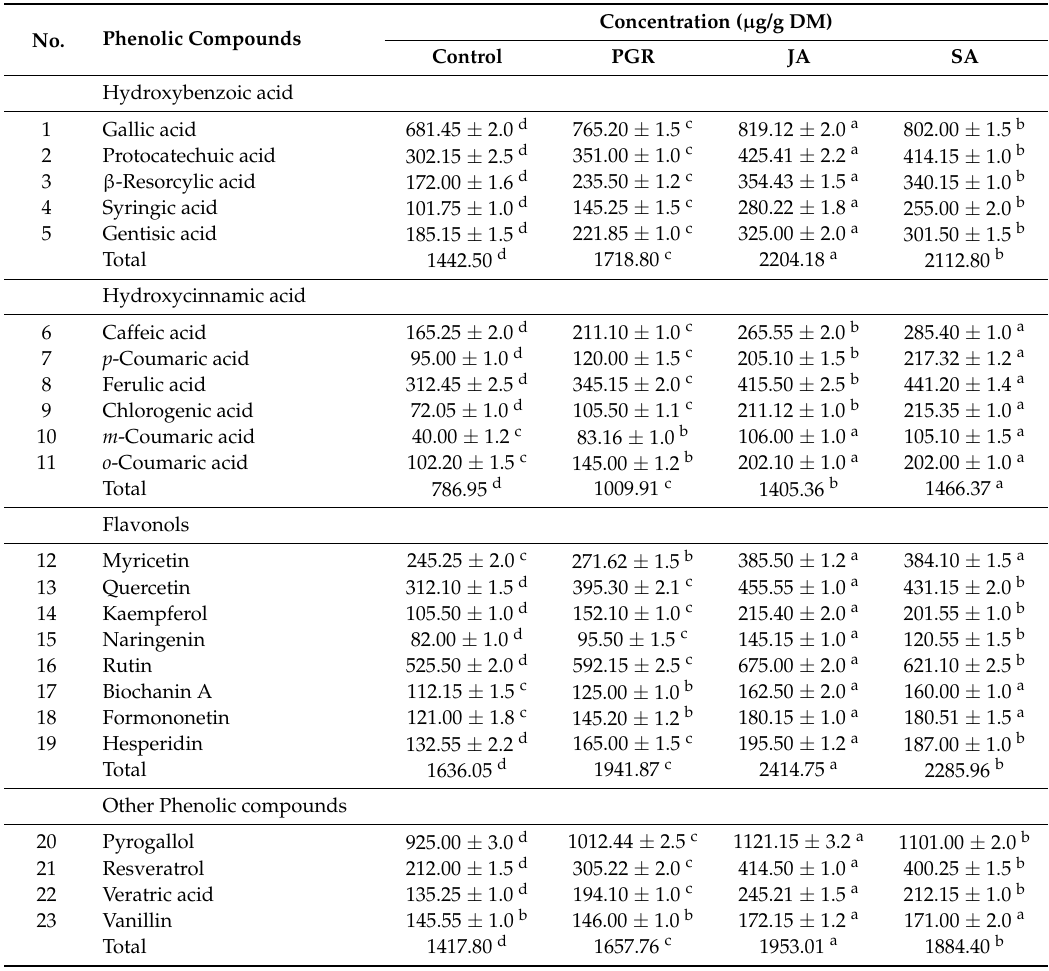
Table 1. Ultra-high performance liquid chromatography (HPLC) analysis of the main phenolic compounds in cell suspension cultures of P. multiflorum